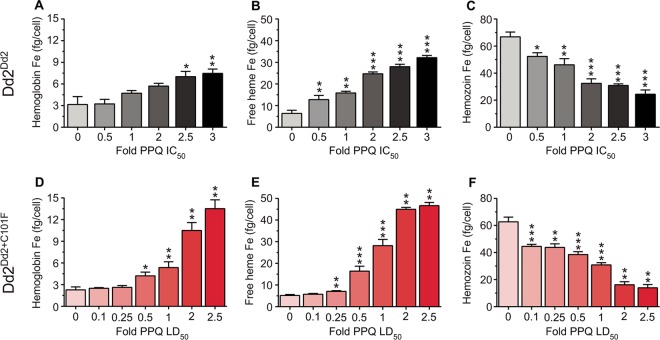
Heme fractionation of piperaquine (PPQ)-treated Dd2Dd2 and Dd2Dd2+C101F (clone 1). (A to C) Amounts of (A) hemoglobin Fe (femtograms per cell), (B) free heme Fe (femtograms per cell), and (C) hemozoin Fe present in Dd2Dd2 treated with increasing concentrations of PPQ (used at multiples of the Dd2Dd2 PPQ IC50). (D to F) Amounts of (D) hemoglobin Fe, (E) free heme Fe, and (F) hemozoin Fe present at increasing concentrations of PPQ-treated Dd2Dd2+C101F clone 1 (multiples of the Dd2Dd2+C101F PPQ LD50). Data are presented as means ± SEM (calculated from 4 to 8 values per concentration). Statistical comparisons of the drug-treated parasites compared to their untreated controls were performed using two-tailed Mann-Whitney U tests. *, P < 0.05; **, P < 0.01; ***, P < 0.001.